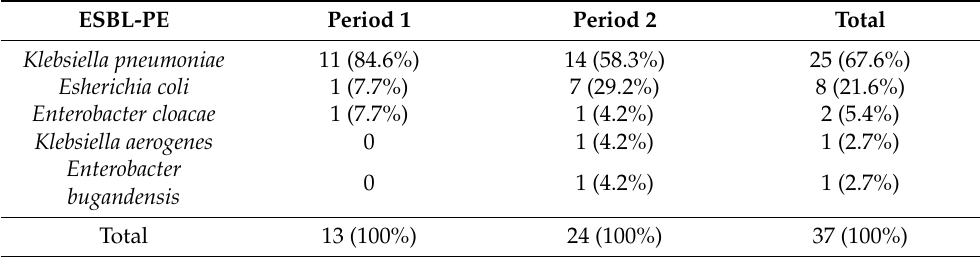
Table 2. The isolated extended-spectrum β -lactamase producing Enterobacterales